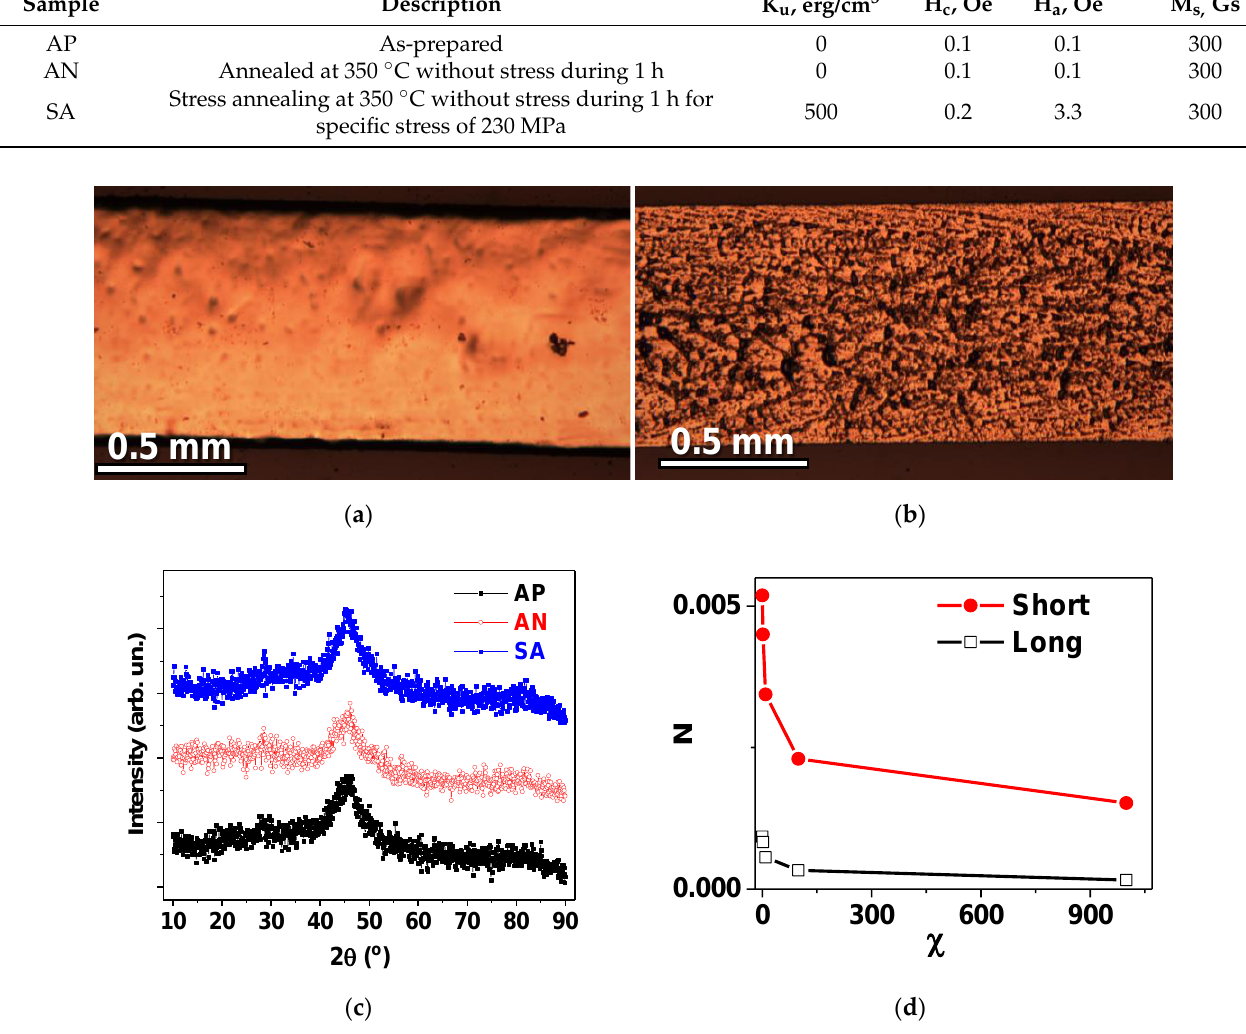
Figure 2. General view of the surface of amorphous ribbons obtained by optical microscopy: free side ( a ) and weal side ( b ) of the Fe 3 Co 67 Cr 3 Si 15 B 12 amorphous ribbon. ( c ) XRD spectra for all types of the samples. ( d ) Demagnetizing factors calculated for selected values of magnetic susceptibility χ and two different lengths of the samples: l = 5 mm for “short” and l = 45 mm for “long” samples. According to electron diffraction data, the samples of Fe 3 Co 67 Cr 3 Si 15 B 12 alloy in all